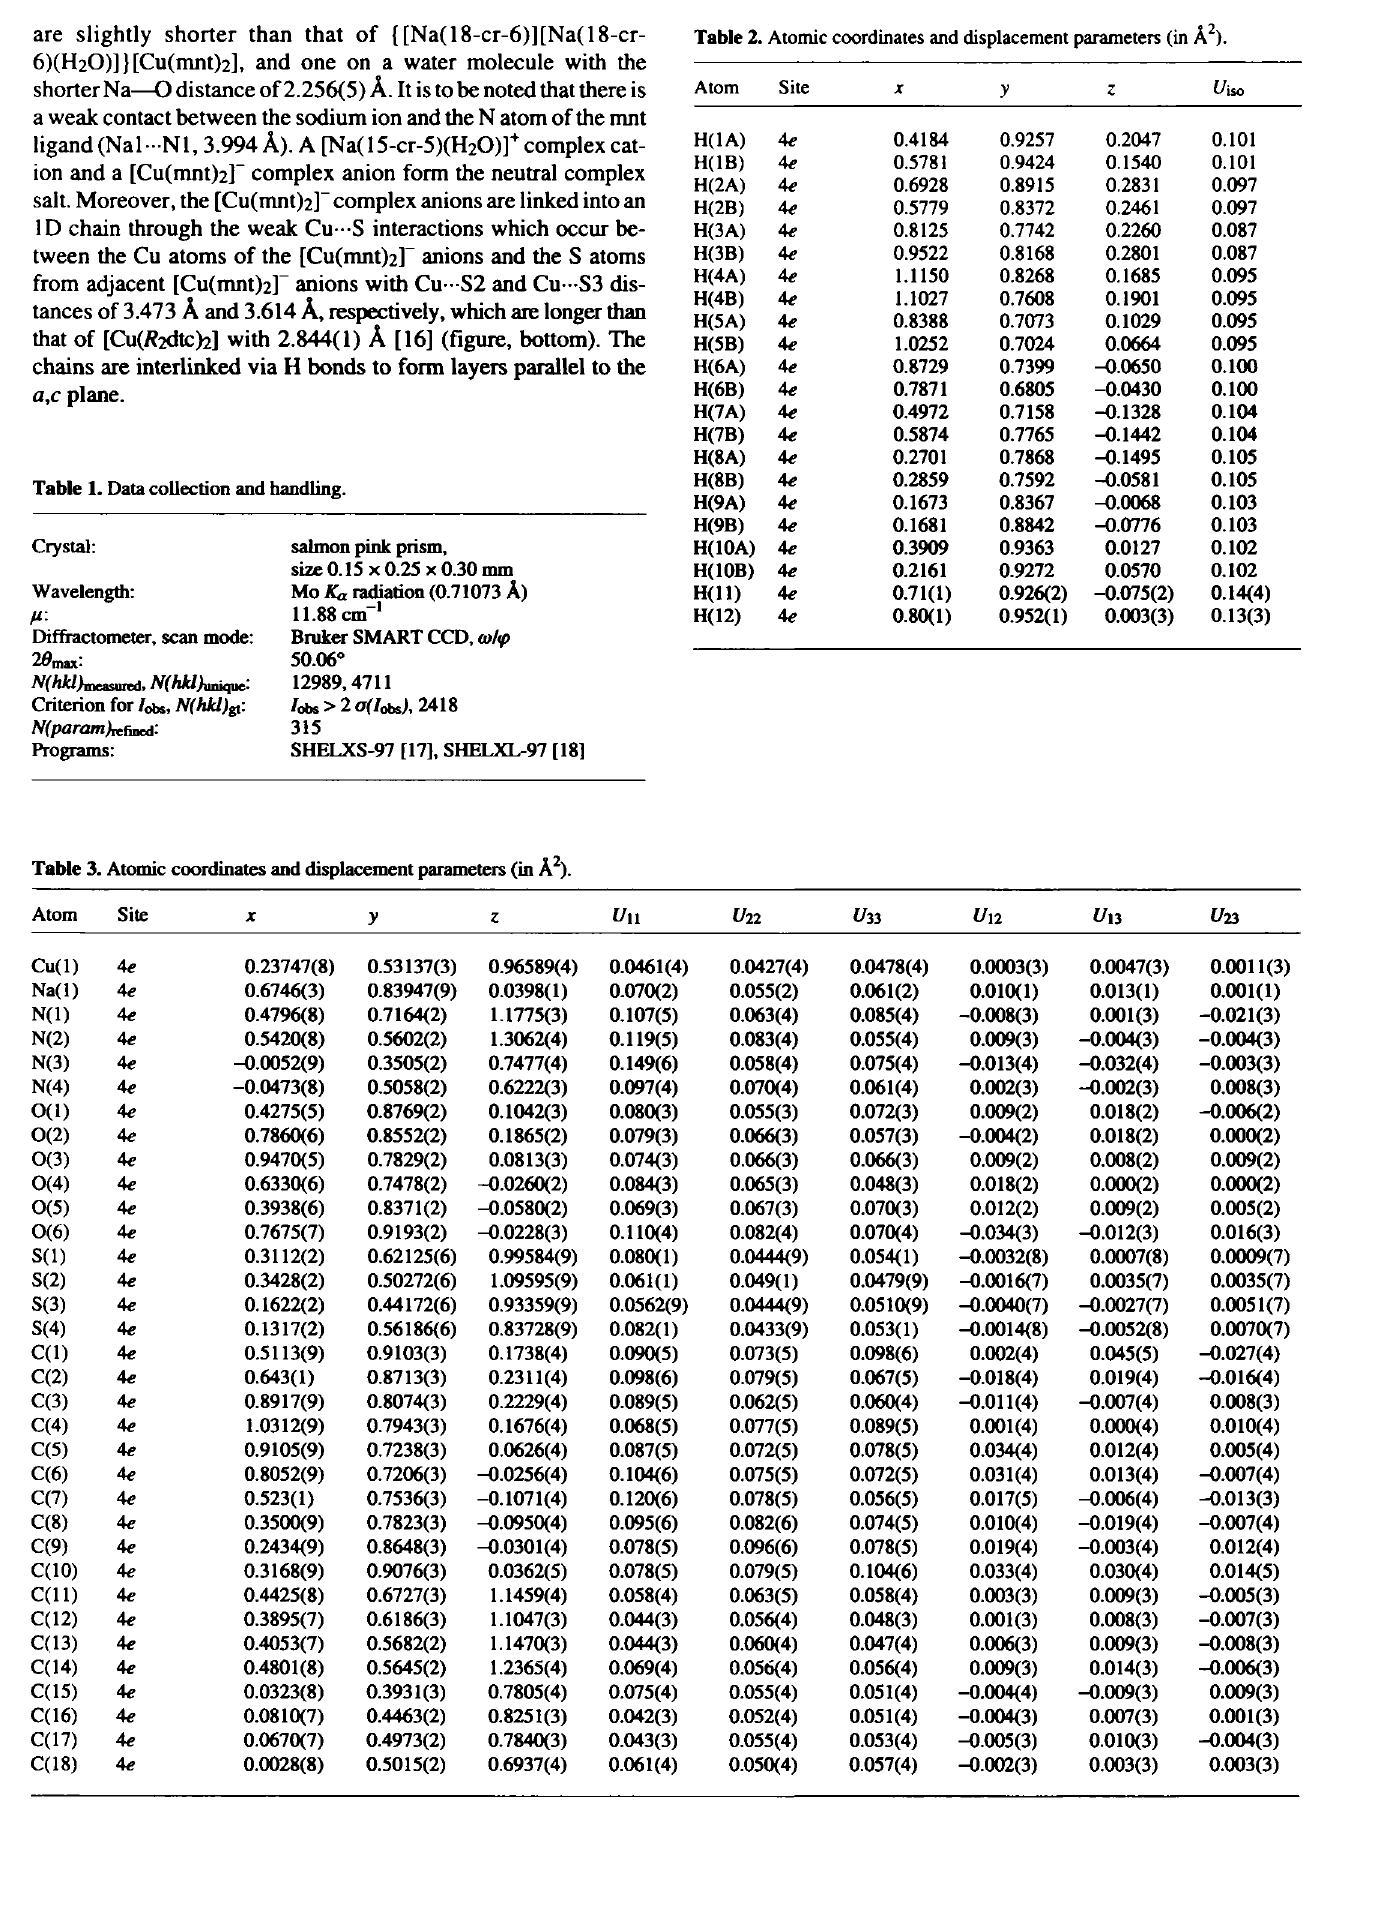
Table 1. Data collection and handling.